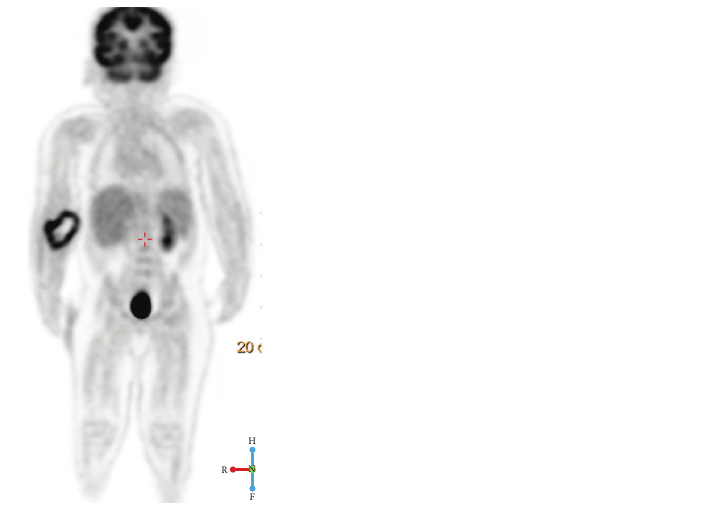
brentuximab (1.8 mg/kg IV), ofatumumab (600 mg/m 2